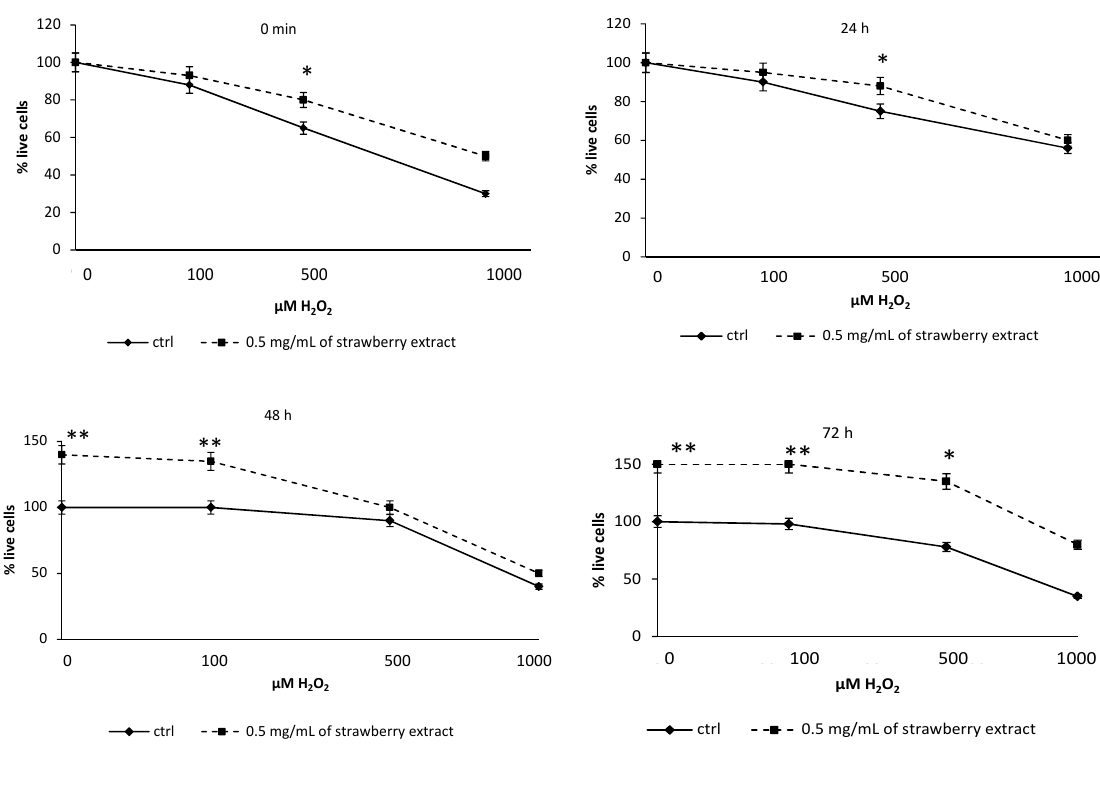
Figure 7. MTT and recovery after stress by H stressed with different concentrations of H different times to assess the percentage of vitality. At 0 and 24 h after stress, the difference from controls was significant for concentrations of hydrogen peroxide ≥ 500 mM. After 72 h the two curves differed for all the experimental points. Data are expressed as mean ± SEM for eight replicas ( n = 8) of three independent experiments. Statistical analysis was performed with the T-test. * p < 0.05 significantly different from control, ** p < 0.01 highly